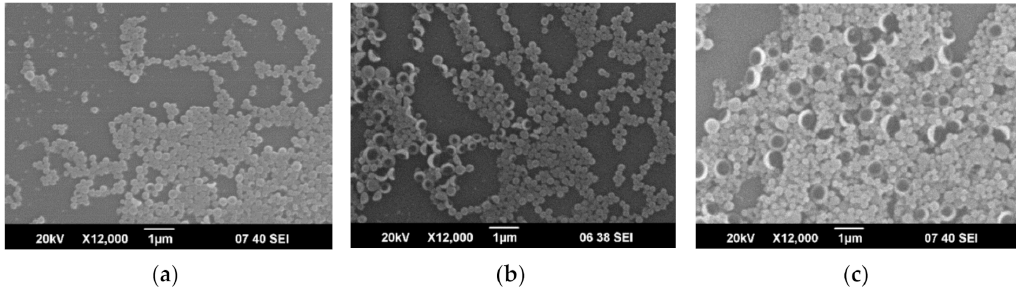
Figure 5. SEM images of PyrSMCs depending on pyraclostrobin concentration in oil phase. ( a )—1%; ( b )—5%; ( c )—10%.